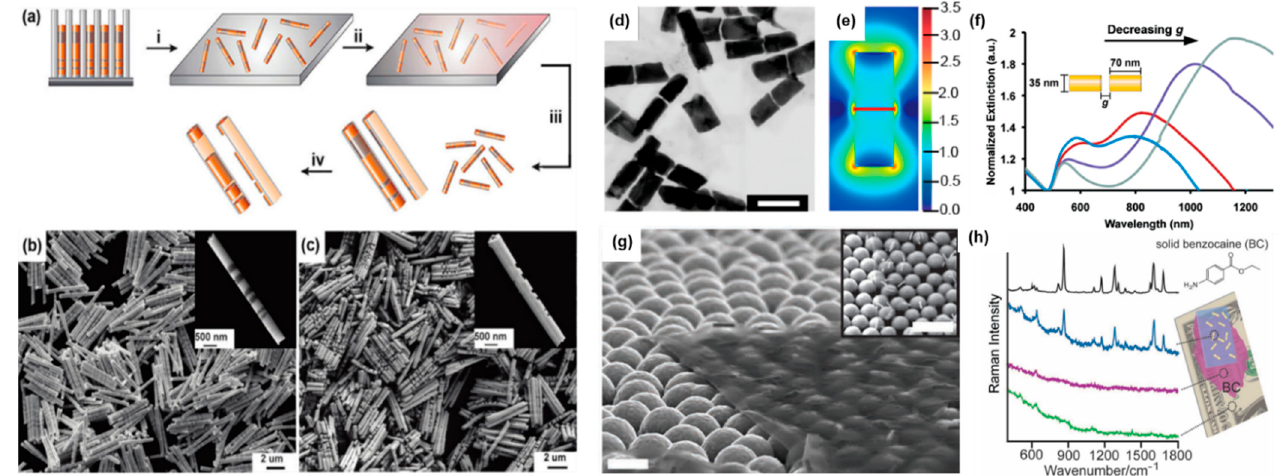
Figure 11. On-wire lithography. ( a ) OWL synthetic scheme describing (i) dispersal of multisegmented nanowires onto a substrate, (ii) deposition of a thin backing layer (i.e., SiO 2 ) on the nanowires, (iii) sonication to disperse the wires back into solution, (iv) selective etching of sacrificial segments. ( b , c ) SEM images of Au–Ag nanowires before ( a ) and after ( b ) selective etching of sacrificial Ag segments. ( d ) TEM image of Au NR dimers. Scale bars are 100 nm. ( e ) Simulated E-field enhancement around a Au NR dimer with dimensions such as the one shown in ( d ) with a 785 nm excitation wavelength and polarization along NR length axis. Log scale for clarity. ( f ) Extinction spectra of Au NR dimers with different gap sizes. ( g ) SiO 2 nanosheets with embedded Au NR dimers on SiO 2 microspheres. Scale bars are 400 nm and 1 µm for ( g ) and the inset, respectively. ( h ) Detection of benzocaine on the surface of a dollar bill. The black spectrum is of crystalline benzocaine and the green spectrum is of the dollar bill without benzocaine. Spectrum with the nanosheets (blue) clearly shows Raman peaks arising from benzocaine; without the nanosheets no appreciable signal correlating to benzocaine can be seen (purple). ( a ) Reprinted with permission from ref. [24]. Copyright 2011 American Chemical Society. ( b , c ) From ref. [29]. Reprinted with permission from AAAS. Copyright 2005 . ( d , e ) Reprinted with permission from ref. [107]. Copyright 2012 American Chemical Society. ( f ) Reprinted with permission from ref. [106]. Copyright 2011 American Chemical Society. ( g , h ) Reprinted from ref. [48]. Copyright 2012 Wiley-VCH.